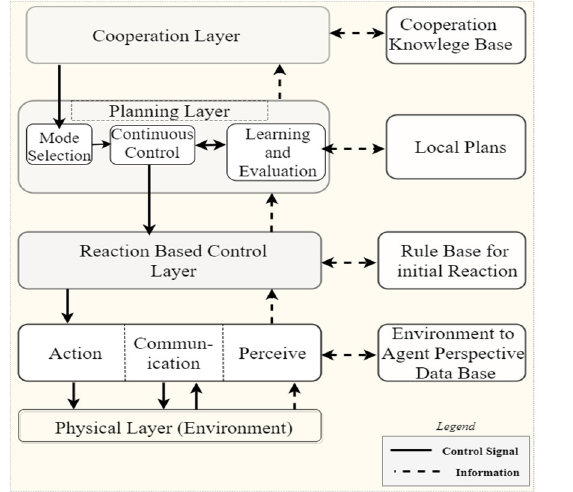
Fig. 4: Layered architecture of a software